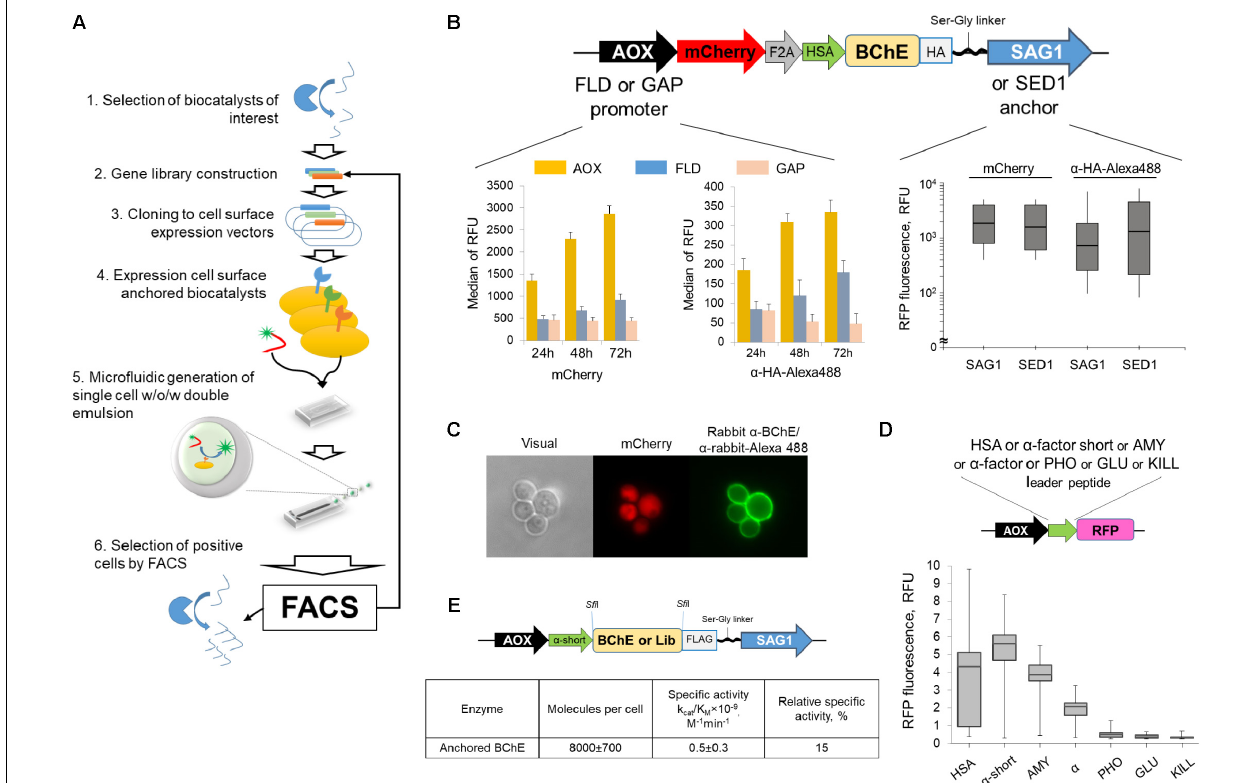
FIGURE 1 | (A) The scheme of the universal ultrahigh-throughput screening (uHTS) platform for biocatalysts selection. For the selected biocatalyst (1) the gene library is constructed (2). The library is further cloned into the specialized vectors (3) and transformed into the Pichia pastoris yeast cells, that present biocatalysts on the cell surface (4). The cells with displayed biocatalysts are screened by uHTS platform: (5) single cells are compartmentalized in the aqueous droplets of a double w/o/w emulsion with the fluorogenic substrate utilizing microfluidic technology. (6) Droplets with cells expressing active enzyme and therefore containing the fluorescent product are sorted by FACS. (B) Optimization of the plasmid vector for cloning of the BChE library for expression of the enzyme on the yeast cell surface. Scheme of the genetic constructs for expression of enzyme exposed on the cell surface (top). Comparative analysis of the surface-displayed BChE expressed under control of different promoters (left panel) and amount of BChE displayed on the cell surface promoted by different polypeptide anchors (right panel). (C) Extracellular release of the RFP, fused with different signal peptides. The genetic construct is presented on top. (D) Staining of yeast cells transformed by genetic construct (shown on top) by polyclonal anti-BChE antibodies (green fluorescence). Red fluorescence corresponds to the intracellular expression of the mCherry. (E) The scheme of the optimized genetic construct coding for the BChE variants used for uHTS (top). Analysis of enzymatic activity of surface-displayed WT BChE by Ellman’s assay.